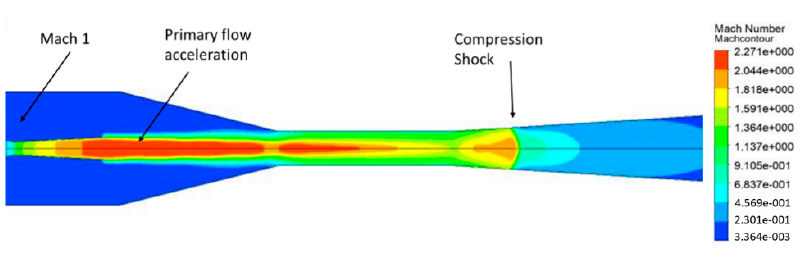
Figure 6. CFD results and validation: Mach contours with R141b working fluid for model from [25,34] .